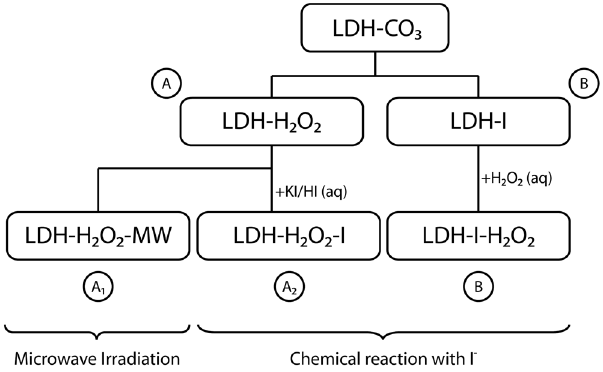
Figure 1. Schematic overview of the three porous LDH synthesis routes.